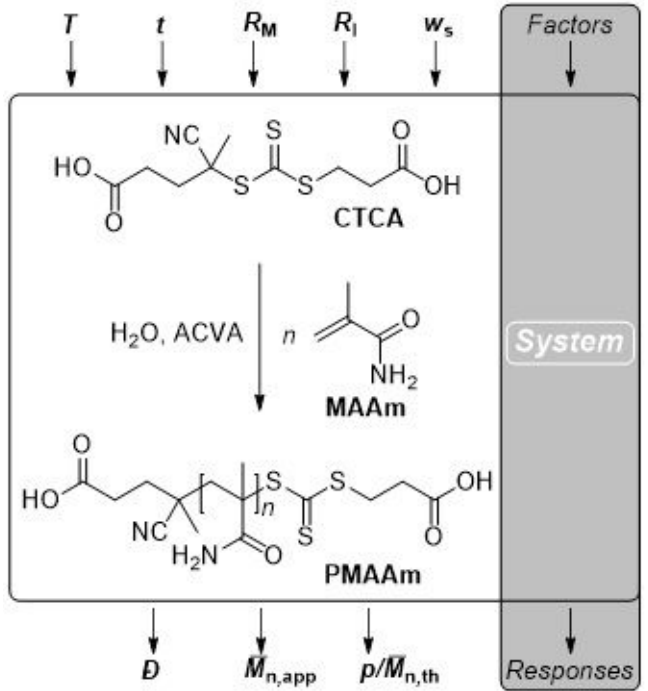
Figure 2. Polymerization of MAAm in aqueous solution utilizing CTCA as RAFT agent and ACVA as initiator. The responses of the polymerization system dispersity Ð , apparent number averaged molecular weight M n,app , and monomer conversion p (as well as the theoretical number averaged molecular weight M n,th , which is proportional to p ) are influenced by the factors of reaction tempera- ture T , reaction time t , the initial concentration ratios of [MAAm]/[CTCA] R M and [ACVA]/[CTCA] R I , and the total solid content w s